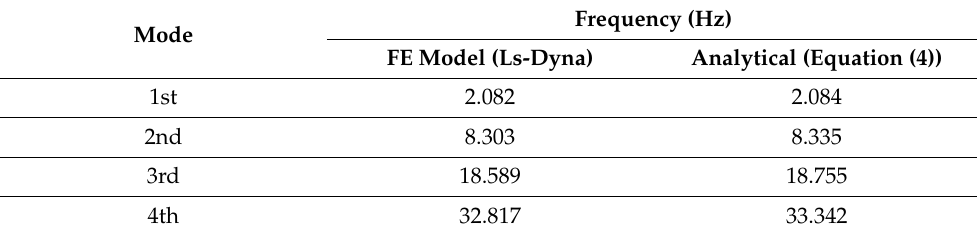
Table 1. Bridge eigenvalues obtained from the FE model and analytical formulation.